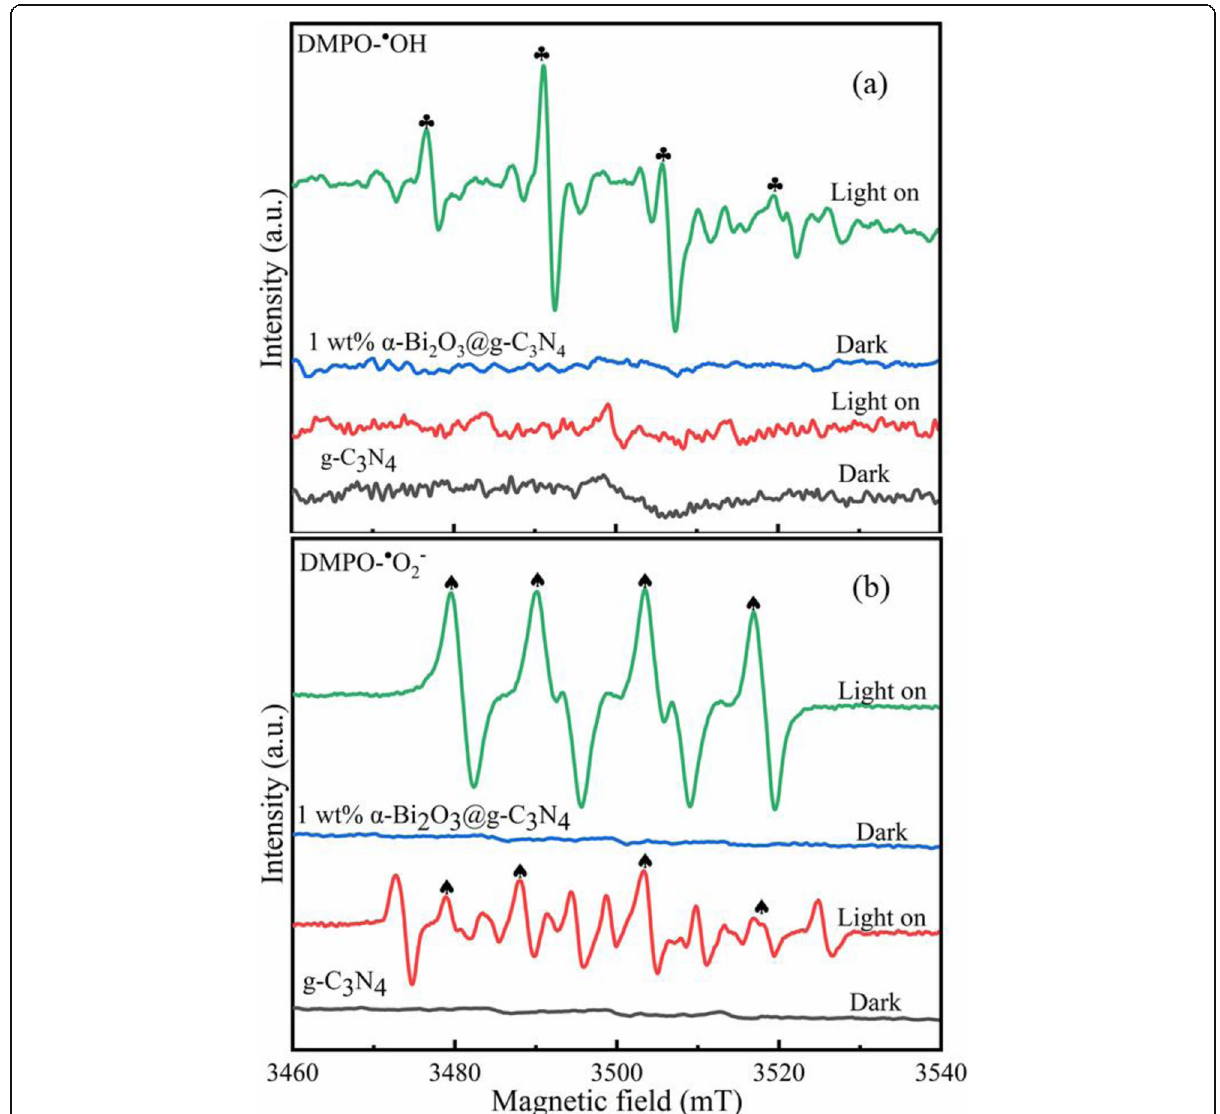
Fig. 10 EPR spectra of the ( a ) DMPO- (cid:129) OH adduct in aqueous dispersion and ( b ) DMPO- (cid:129) O 2 − adduct in methanol dispersion for the 1 wt% α - Bi 2 O 3 @g-C 3 N 4 composite and g-C 3 N 4 under